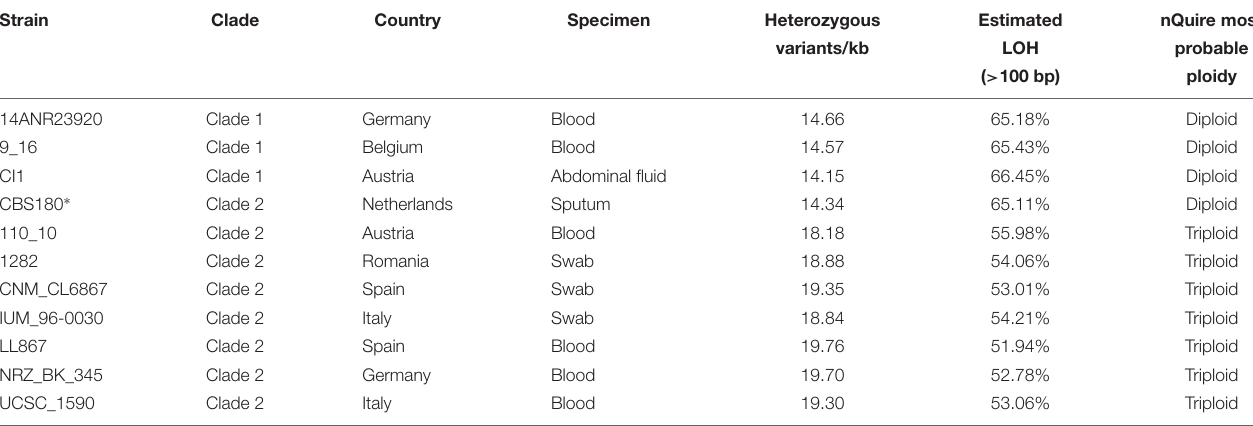
TABLE 1 | List of Candida inconspicua strains used in this project, with indication of their respective clade, place of collection, specimen, number of heterozygous variants, level of loss of heterozygosity, and estimated overall ploidy. Strain Clade